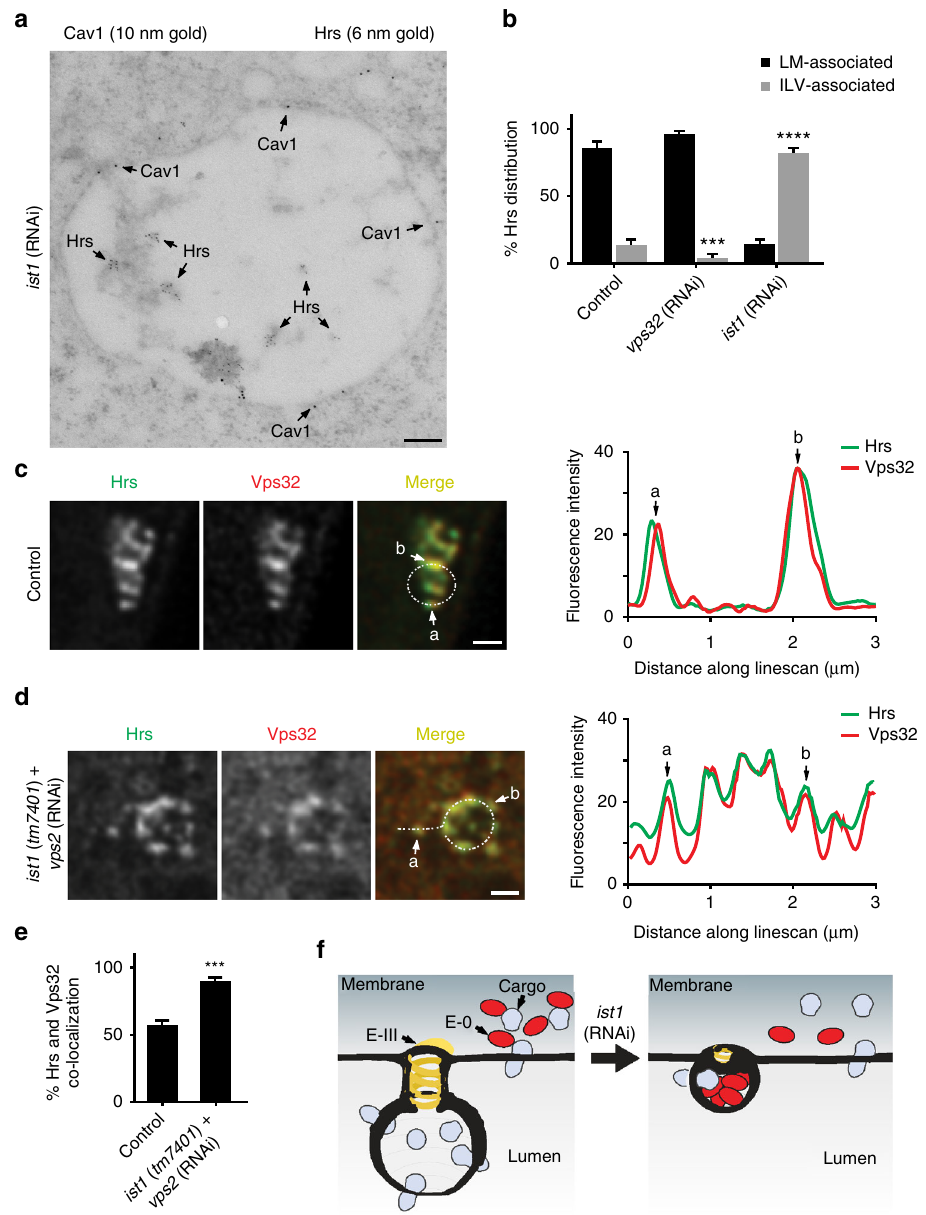
Fig. 6 Ist1 inhibits the incorporation of ESCRT-0 into ILVs. a Immunogold labeling was used to determine the distributions of Cav1 (10 nm gold) and Hrs (6 nm gold) in one-cell stage embryos depleted of Ist1 following high-pressure freezing. The image shown is representative of 64 MVEs analyzed. Bar, 100 nm. b Quanti fi cation of the distribution of Hrs at the limiting membrane and within MVEs in control ( n = 31), Vps32-depleted ( n = 36), and Ist1-depleted ( n